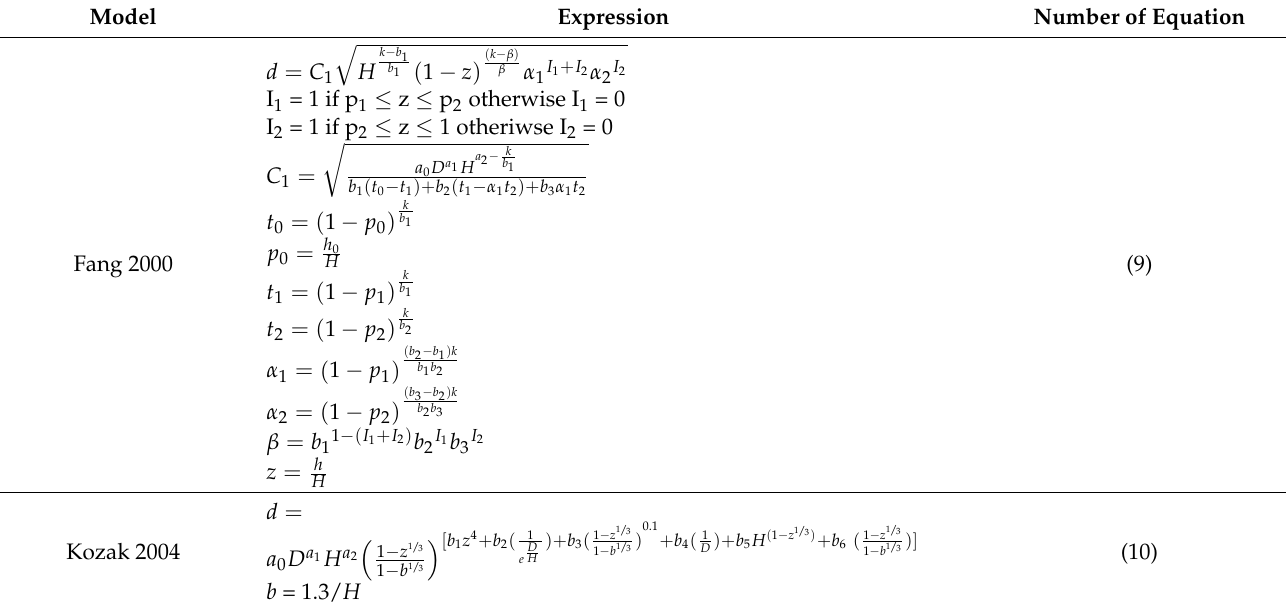
Table 3. Conventional models used for the tapering model adjustment used in this study.